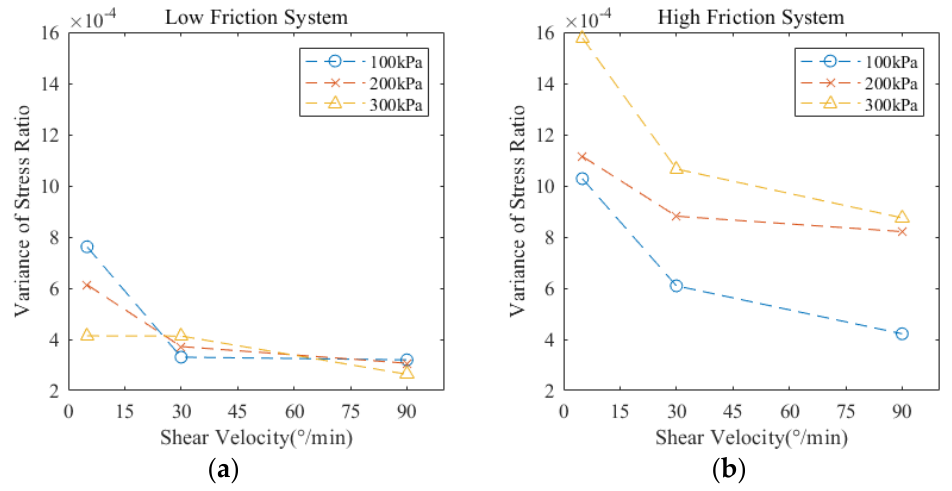
Figure 7. Relationship between shear velocity and the variance of stress ratio under different normal stresses. ( a ) Quartz sand; ( b ) Brecciated corundum.